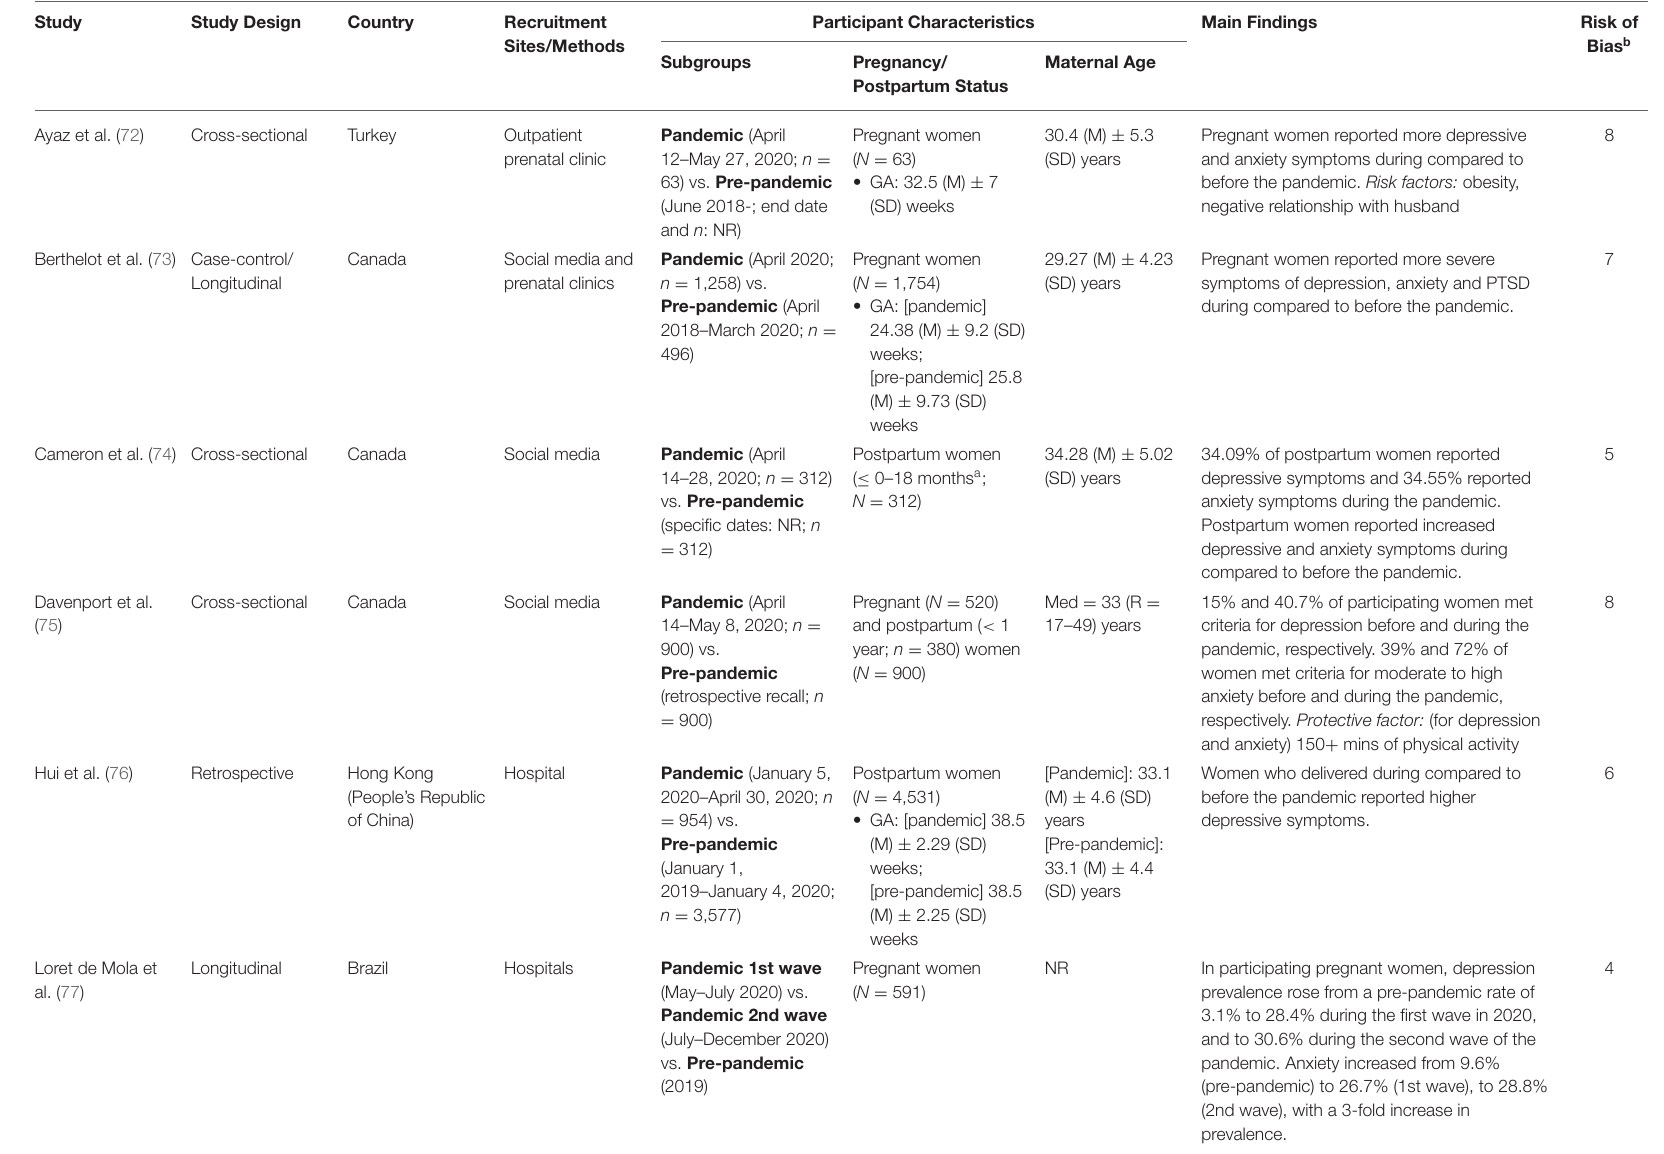
TABLE 2 | Mental health outcomes in pregnant or postpartum women before vs. during the COVID-19